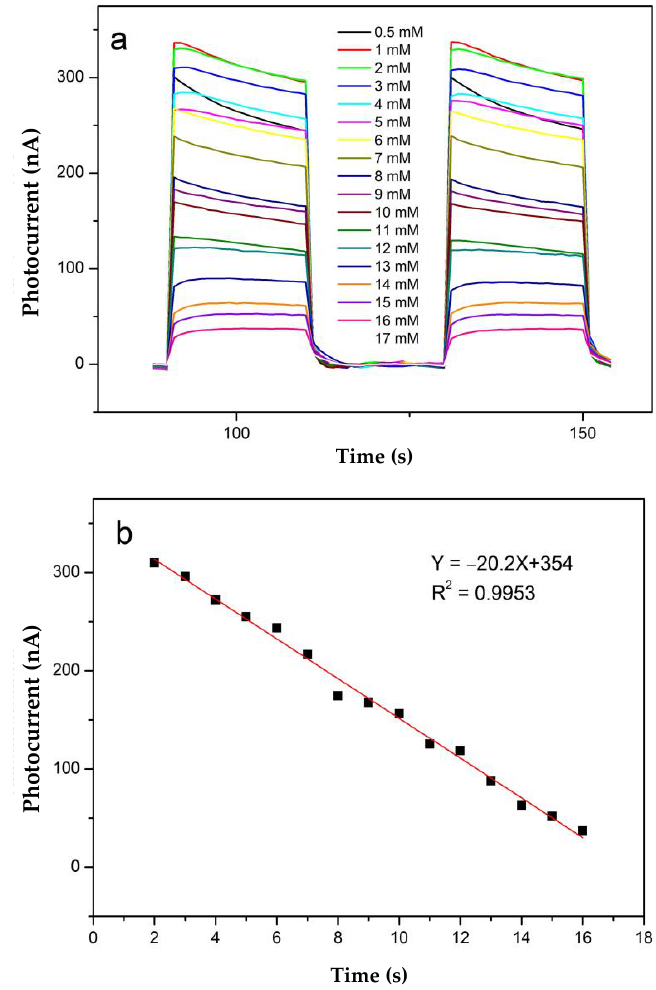
Figure 5. ( a ) Photocurrent response for the detection of different concentrations of GSH (2–16 mM), and ( b ) corresponding photocurrent-GSH concentration curve of the CdS-TiO 2 NTs under irradiation of 429 nm.